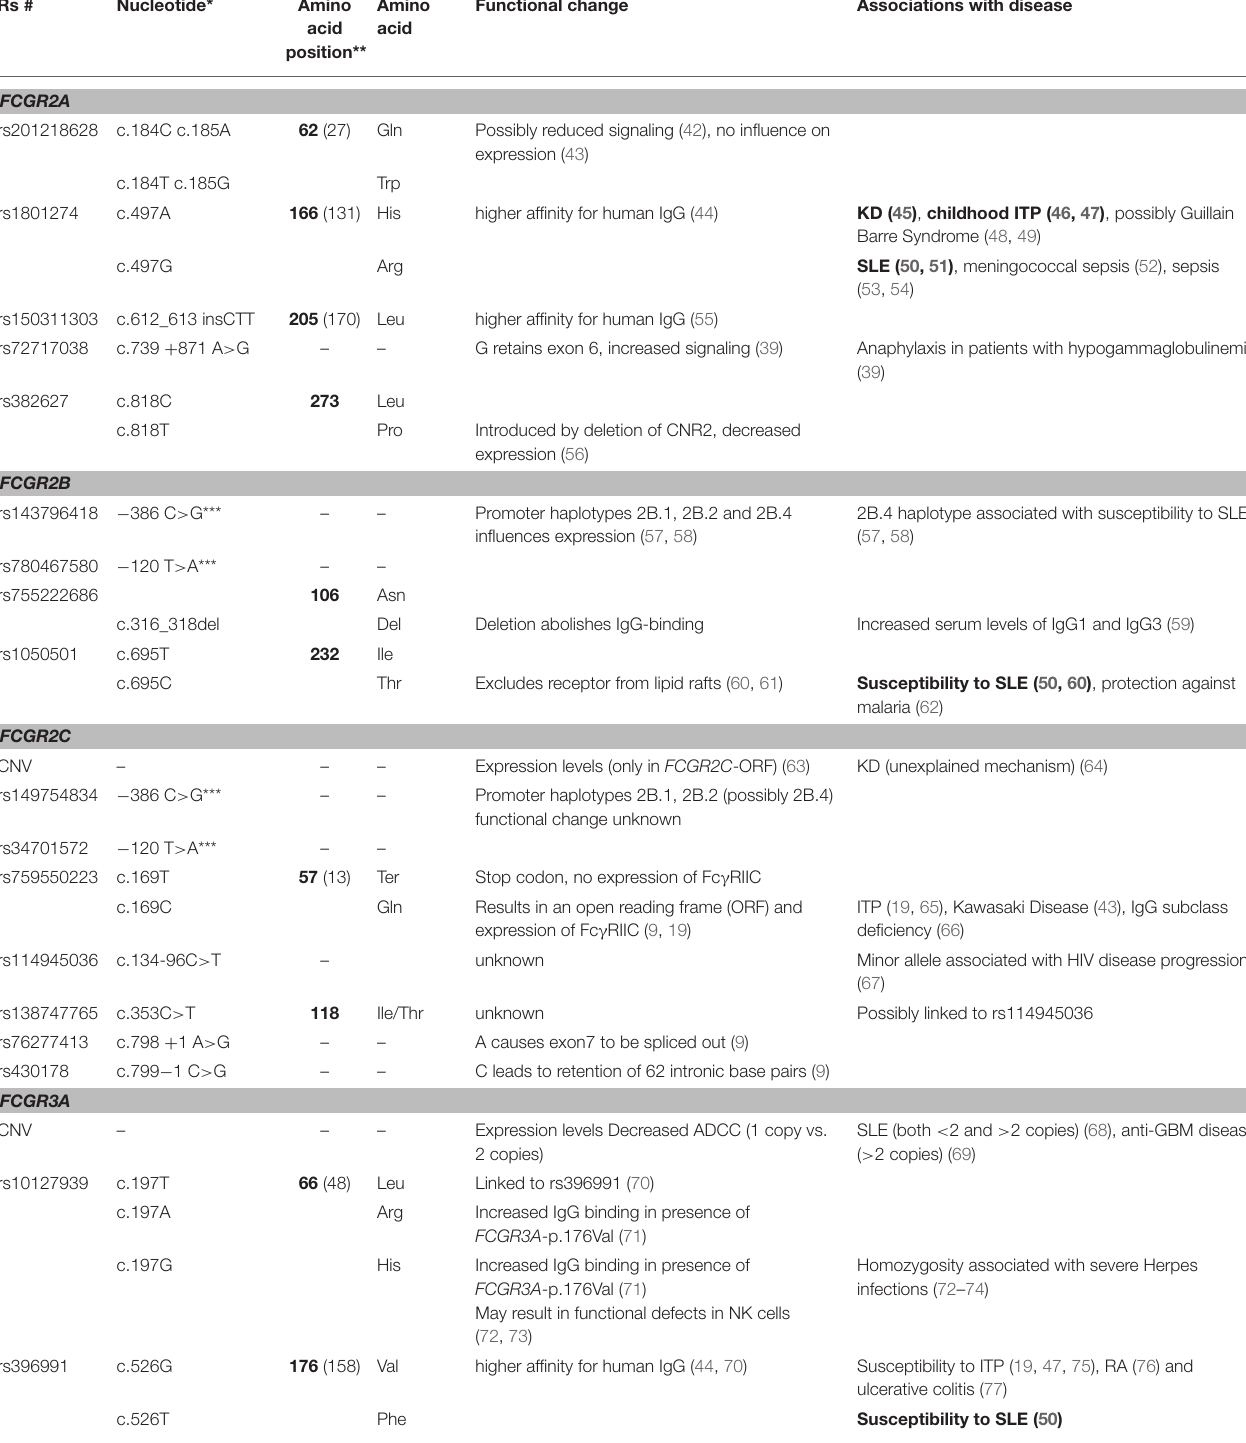
TABLE 1 | Overview of single nucleotide polymorphisms (SNPs) and copy number variation (CNV) at the FCGR2/3 locus. Rs